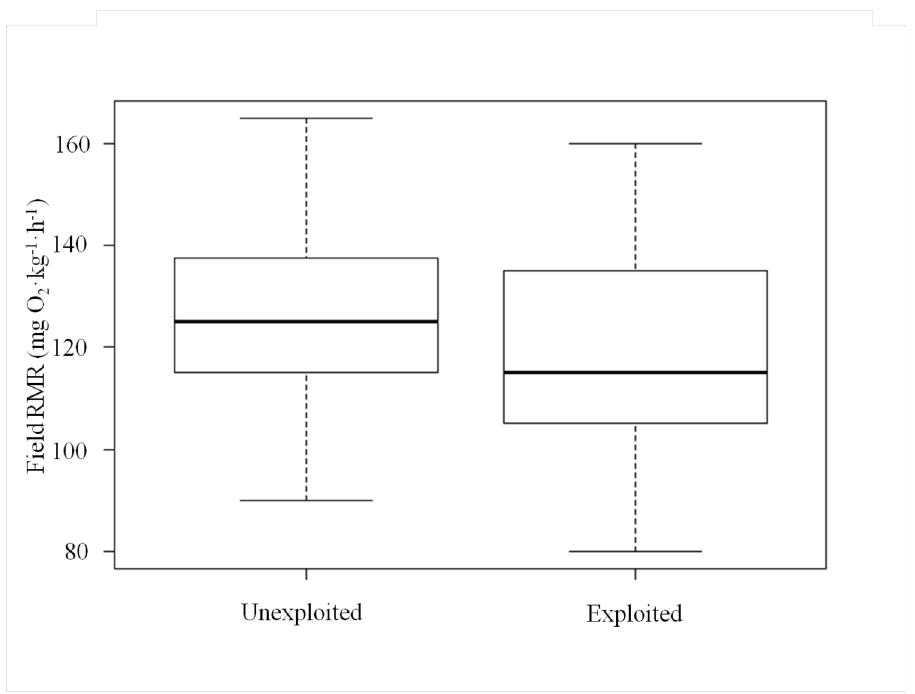
Fig 2. Boxplot of Field Resting Metabolic Rates. Boxplot of field resting metabolic rates of unexploited and exploited populations of Largemouth Bass raised in a common environment. The horizontal black line represents the population median, the top and bottom of each box represent the 75 th and 25 th quartiles respectively.